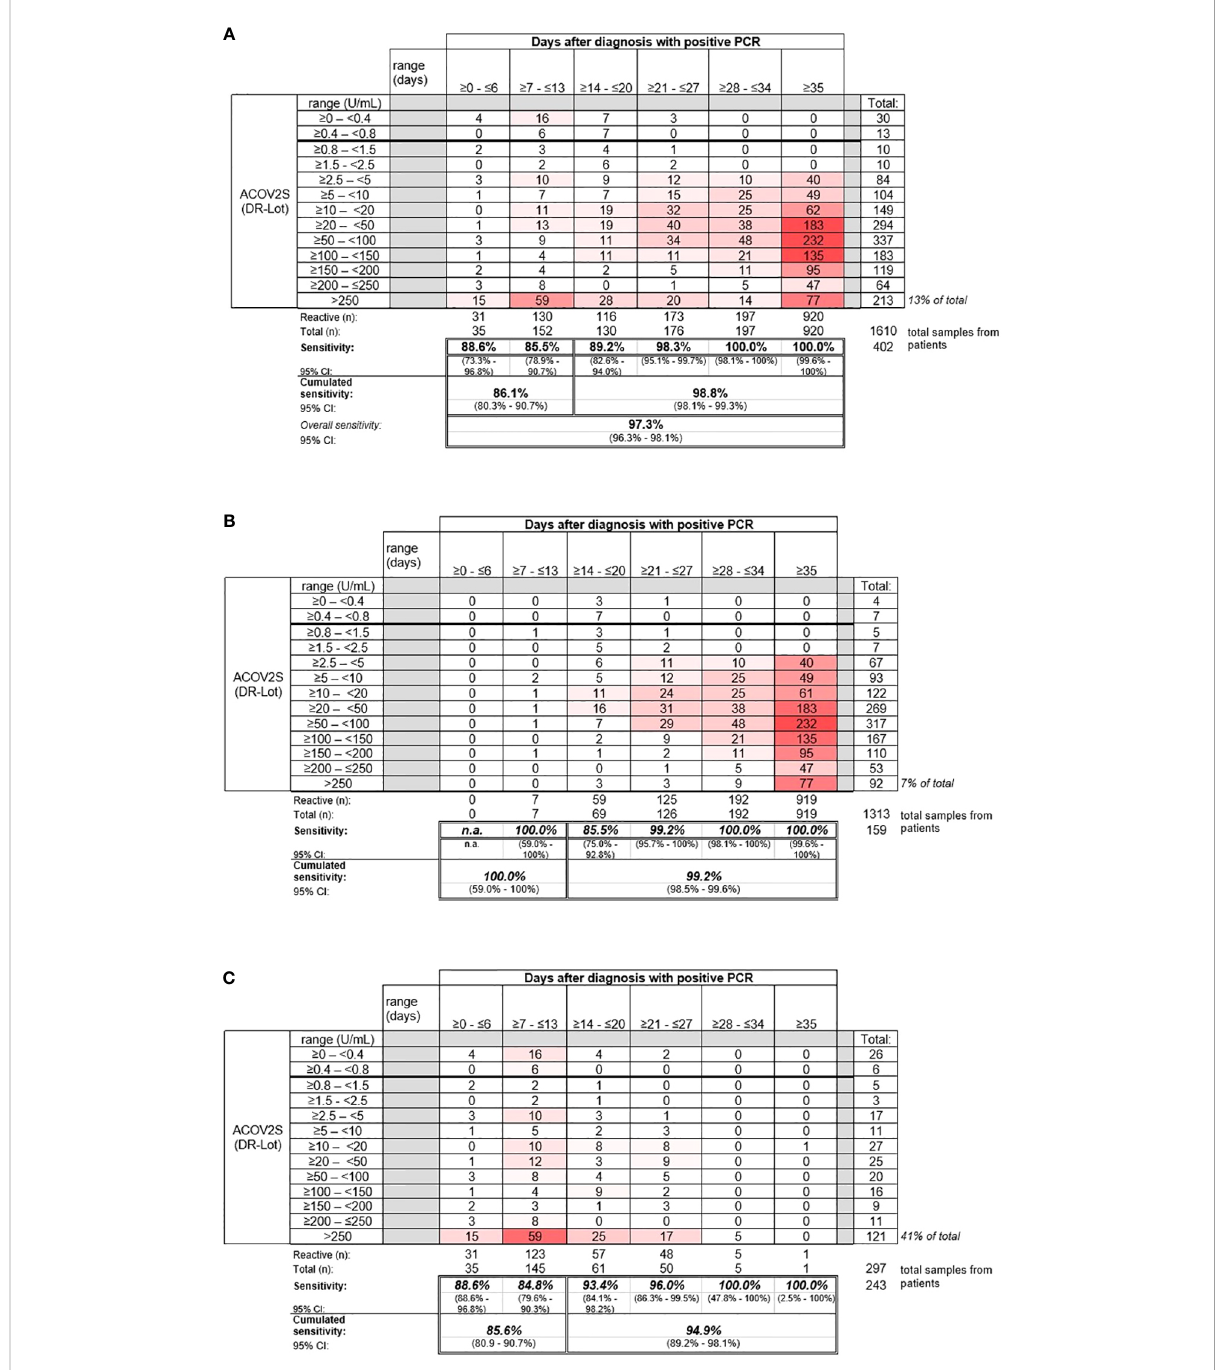
FIGURE 3 Sensitivity of the ACOV2S assay. (A) Sensitivity of the ACOV2S assay in samples from (A) all patients, (B) patients with mild symptoms of COVID-19, and (C) patients hospitalized due to